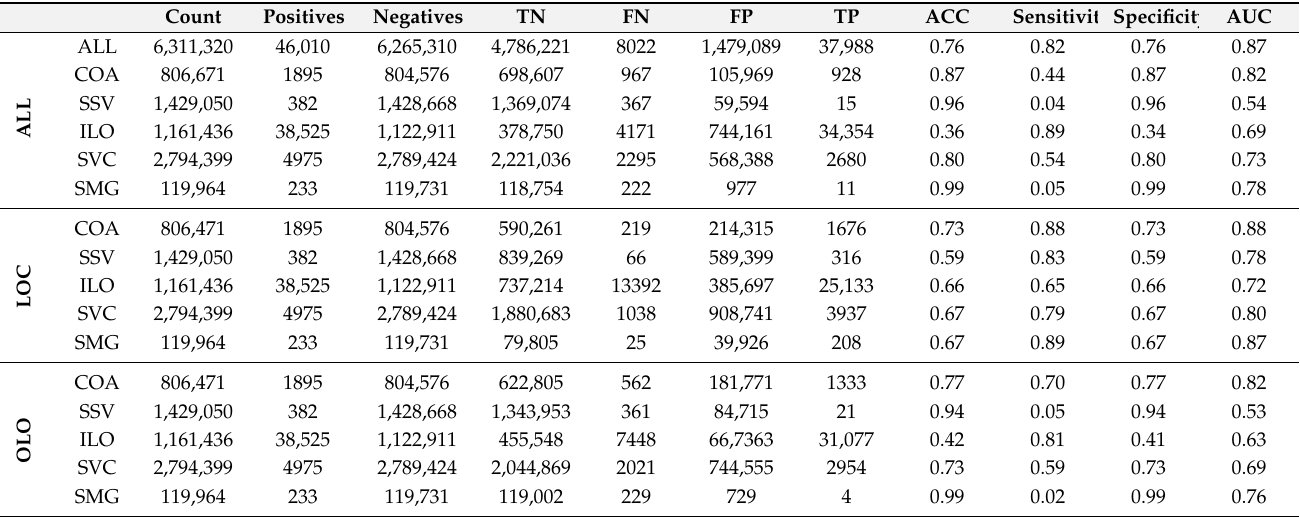
Figure 4. ROC plots and relative AUC values for the OLO models. Table 3. Validation results (confusion matrices) for the sixteen models.